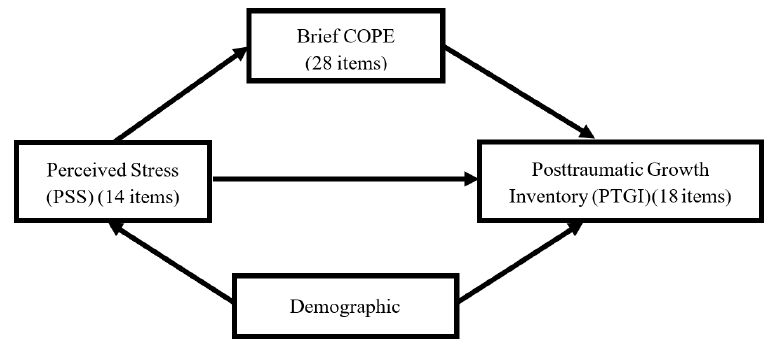
Figure 1. The structure of the research design.